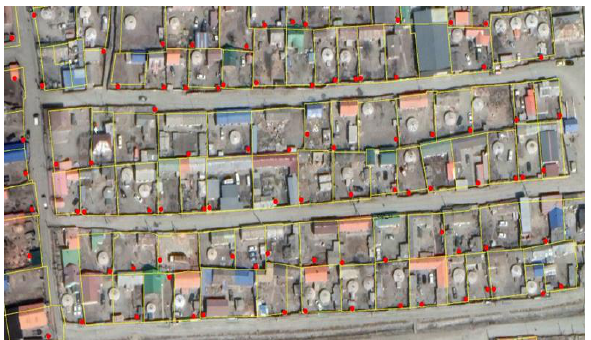
Figure 2. Pit latrines in a ger area